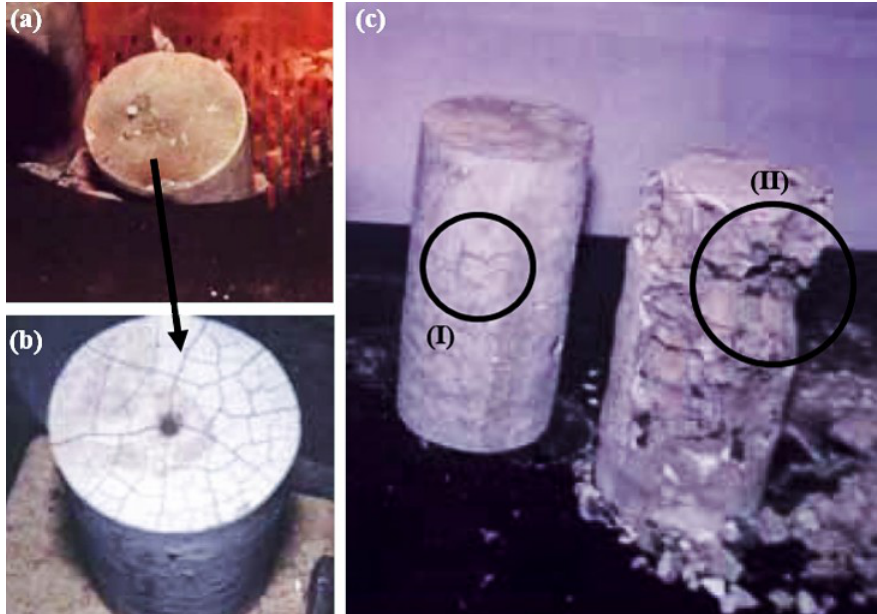
Figure 6. Test specimens ( a ) during heating inside the furnace and ( b ) after slow air cooling, and ( c ) evidence of the fragmentation phenomenon. ( I ) extensive cracking and ( II ) phenomenon of fragmentation.